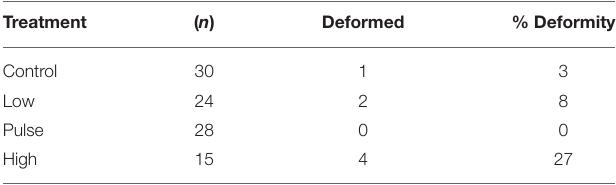
TABLE 3 | Deformities in juvenile Atlantic haddocks surviving early life stage exposure to crude